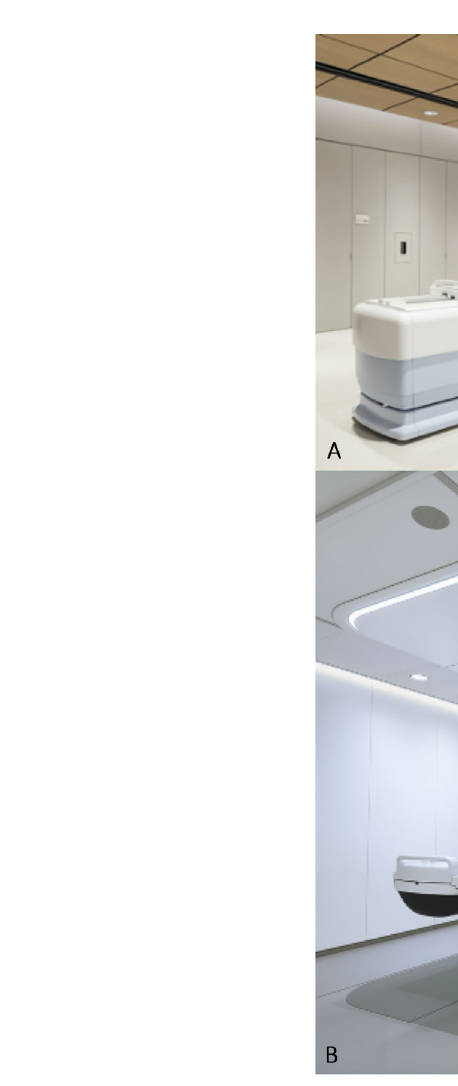
FIGURE 2 | The two commercially available MR-guided radiotherapy systems. (A) The MRIdian (ViewRay Inc, USA). (B) The Unity (Elekta,